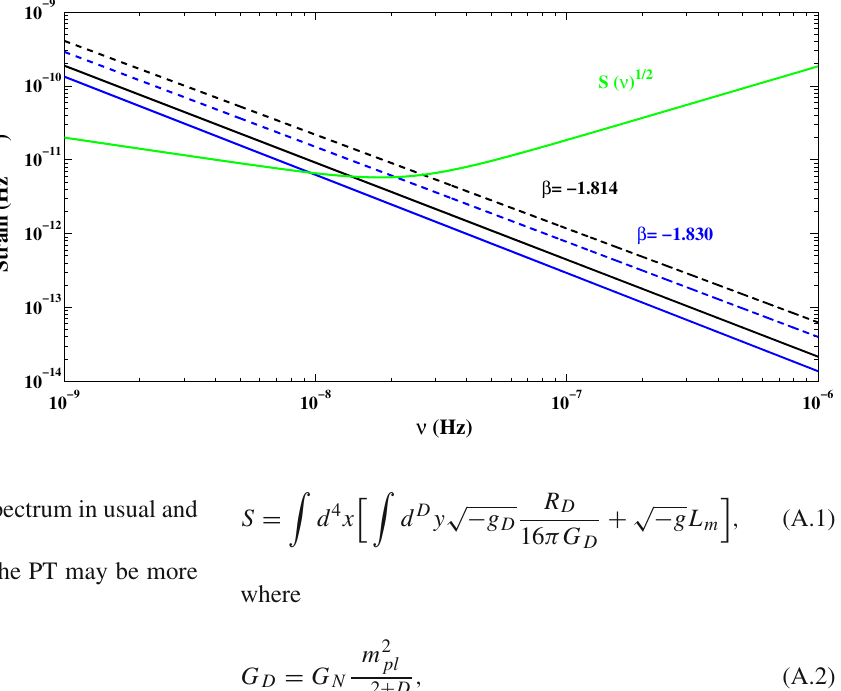
Fig. 2 The spectrum √ h mc (ν) F /ν of RGWs in usual case (solid lines) and thermal case (dashed lines) for two obtained β based on GW150914 data [6] compared to the strain sensitivity of PT (green